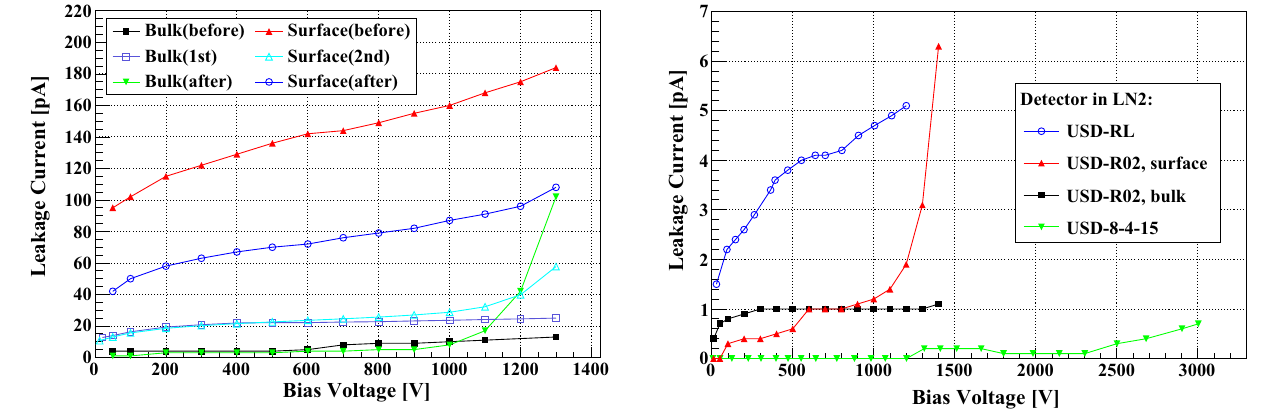
energy resolution and the noise level were similar to those